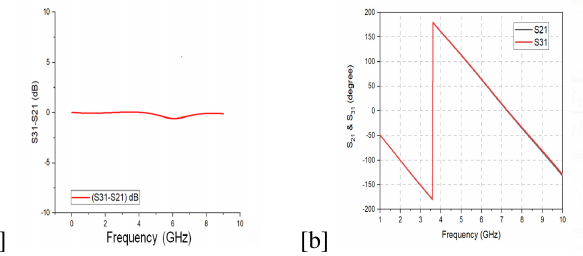
FIGURE 5. (a) Amplitude Difference (b) Phase response at output ports